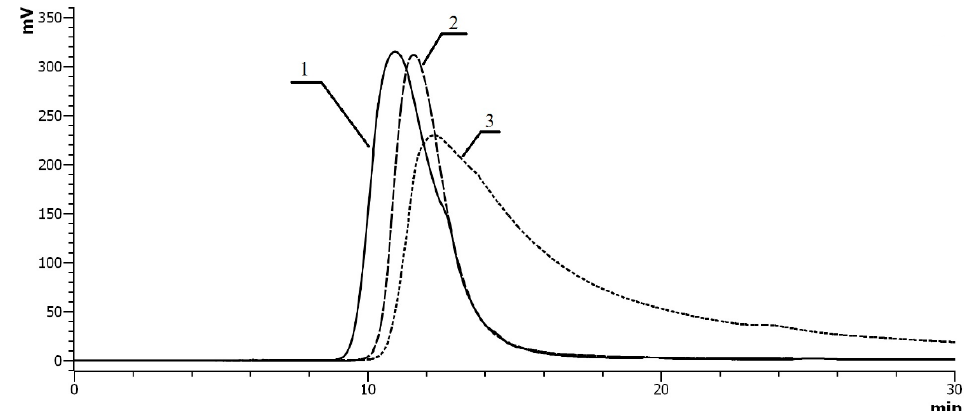
Figure 2. Size exclusion chromatography (SEC) profiles of the VP–VFA (1—solid line), VP–VA · HCl (2—dashed line), and VP–VDTC (3—dash-dotted line) copolymers ( M r = 12 × 10 3 Da, 6 mol.% of NH 2 groups). Ultrahydrogel linear column (7.8 × 300 mm) with a pre-column (0.6 × 40 mm). Eluent: aqueous solution of 0.2 M NaCl, λ = 210 nm.